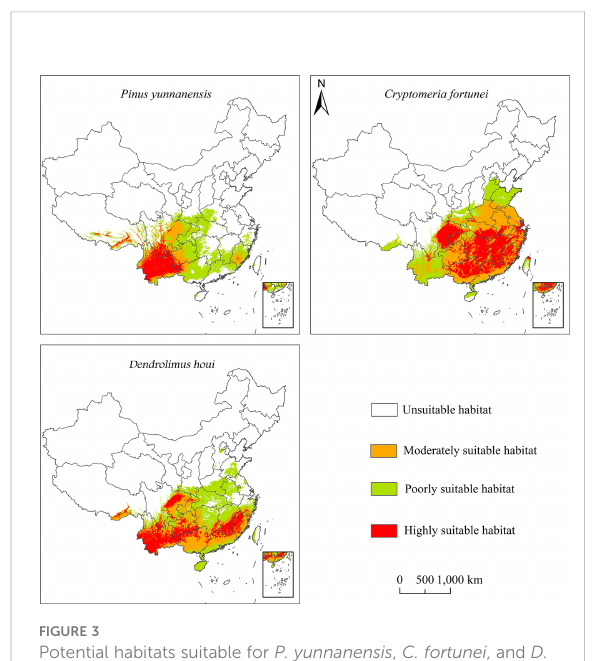
FIGURE 4 Potentially suitable climatic distributions for P. yunnanensis , C. fortunei , and D. houi under different climate-change